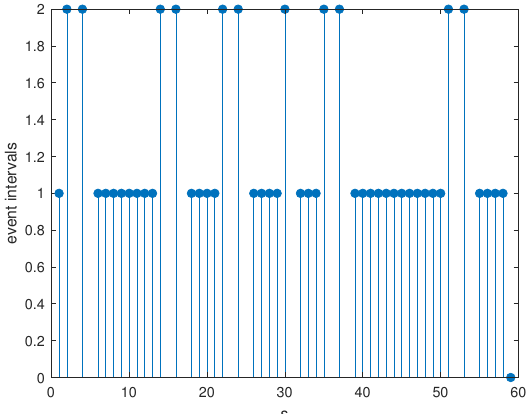
Figure 8. Release intervals with ˆ K and Ω . Compared with the continuous case in the literature [25], the time required for the error system to stabilize in the discrete case will be longer, but the number of event triggers will be significantly less, so as to truly save network space, reduce network pressure, and save